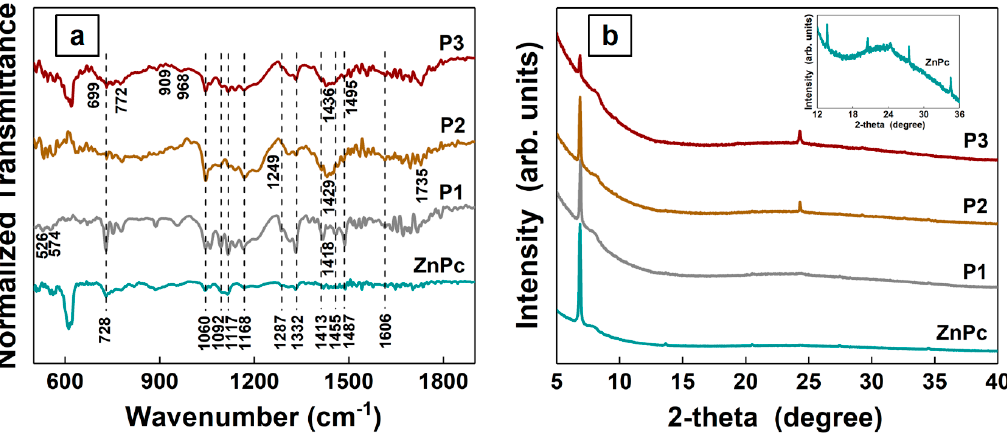
Figure 1. FTIR spectra ( a ) and XRD patterns ( b ) of the MAPLE-deposited organic layers on silicon ( a ) and glass ( b ). and glass ( b